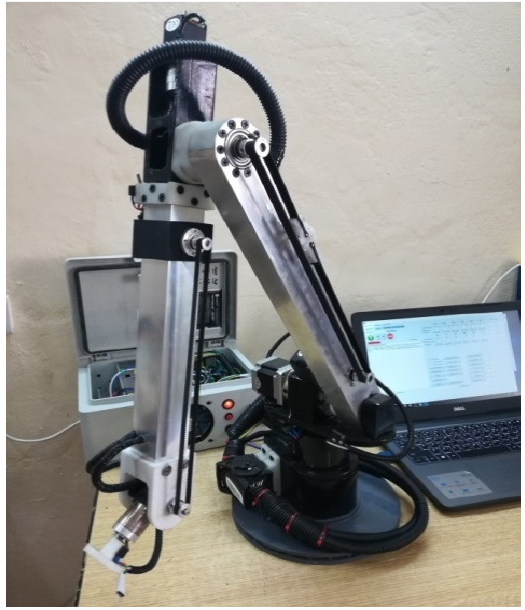
Fig. 1. Three Links Robot Manipulator 6